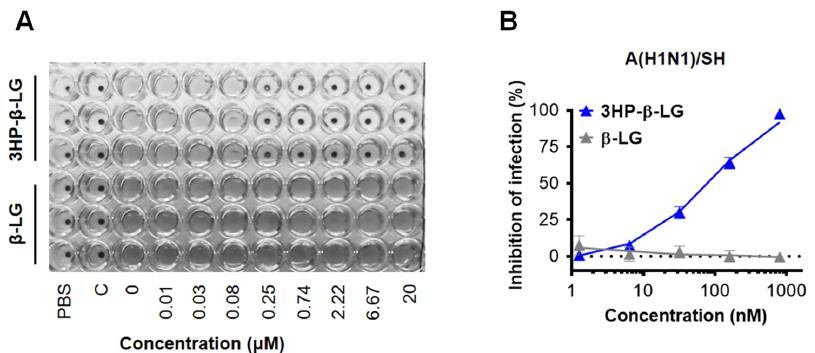
Figure 2. Inhibition of 3HP- β -LG against influenza A(H1N1)/SH virus infection in MDCK cells. ( A ) HI assay. ( B ) CPE reduction assay. ( A ) HI assay. ( B ) CPE reduction